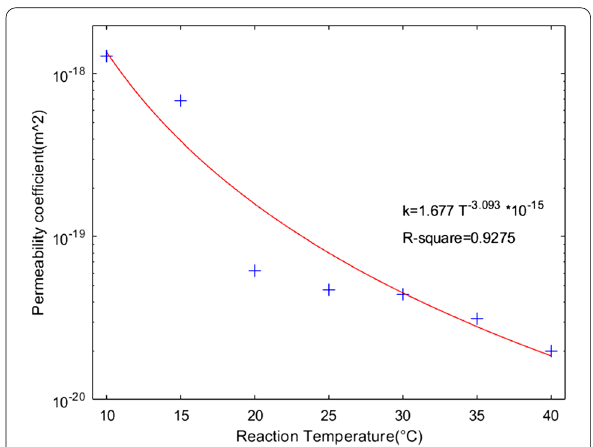
Fig. 12 Fitting curve of permeability coefficient vs. reaction temperature.